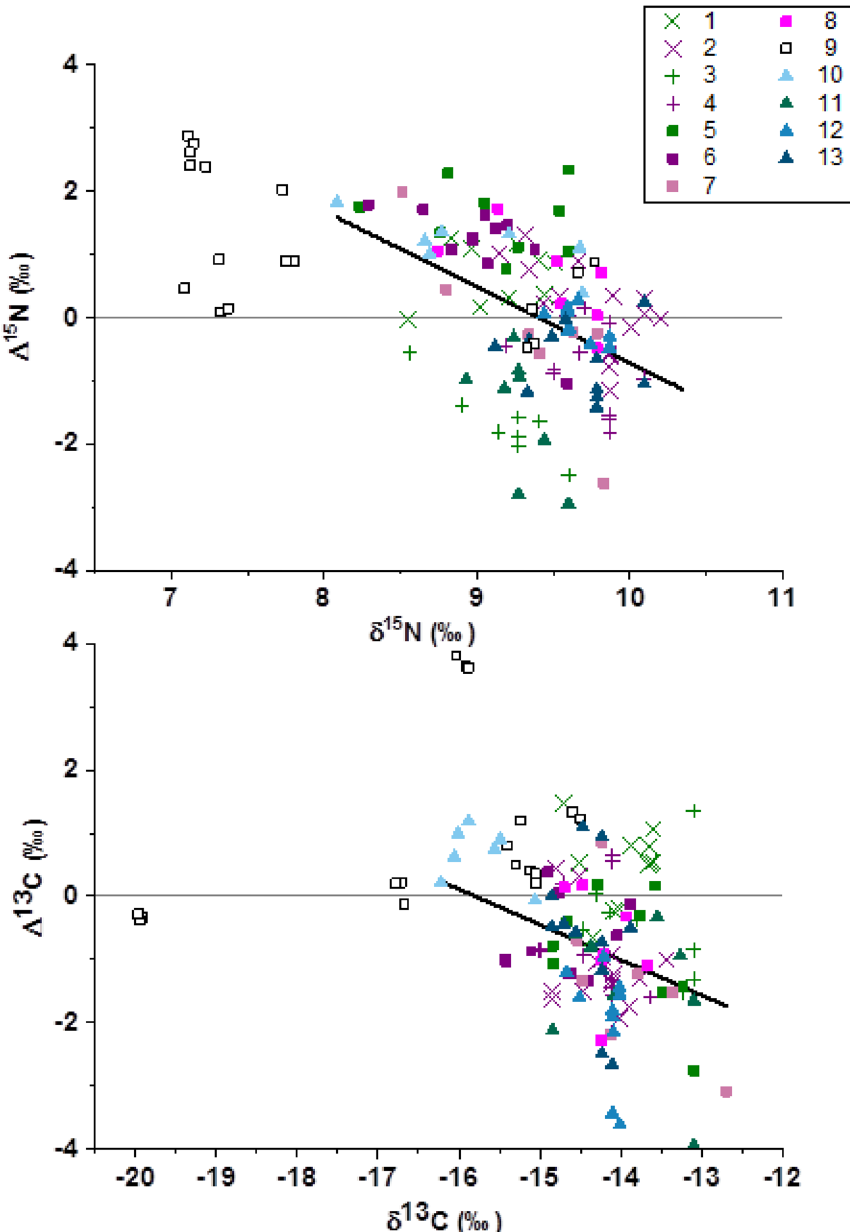
Figure 4. Host δ 15 N values versus Δ 15 N values classified for each individual parasite–host pairing. Labeling follows the pairing order 1–13 from Fig. 2 with X indicating trematodes, + indicating cestodes, squares indicating dietary tract nematodes and triangles indicating general cavity nematodes. Regression lines indicate the significant relationships for the combined pairings from the three predatory (invertivore or piscivore) fish in the dataset (i.e. excluding samples from the herbivore host S. lineatus (open squares, 9)) for nitrogen (slope = − 1.2, R 2 = 0.071, p < 0.001) and carbon (slope = − 0.56, R 2 = 0.196, p =